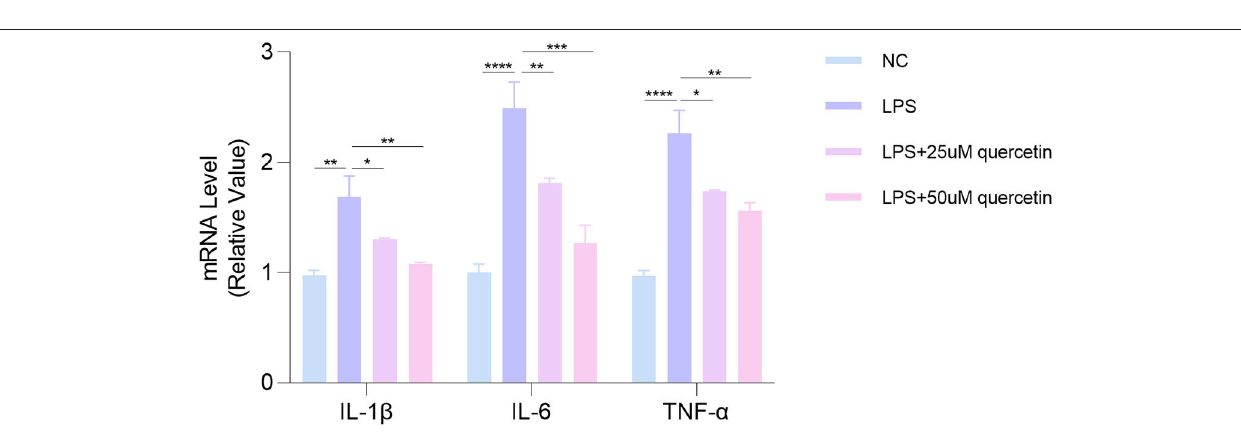
FIGURE 6 | Quercetin attenuates LPS-induced the elevation of pro-inflammatory cytokines of human umbilical vein endothelial cells (HUVECs). Data are listed as mean ± SD of at least three independent experiments. NC, negative control; LPS, lipopolysaccharide. * P < 0.05, ** P < 0.01, *** P < 0.001, **** P <